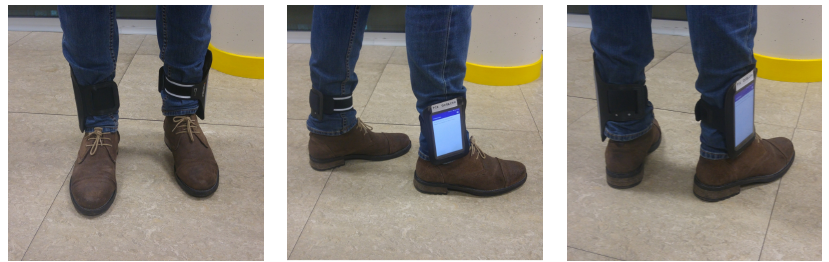
Figure 4. Sports armbands holding the mobiles of the